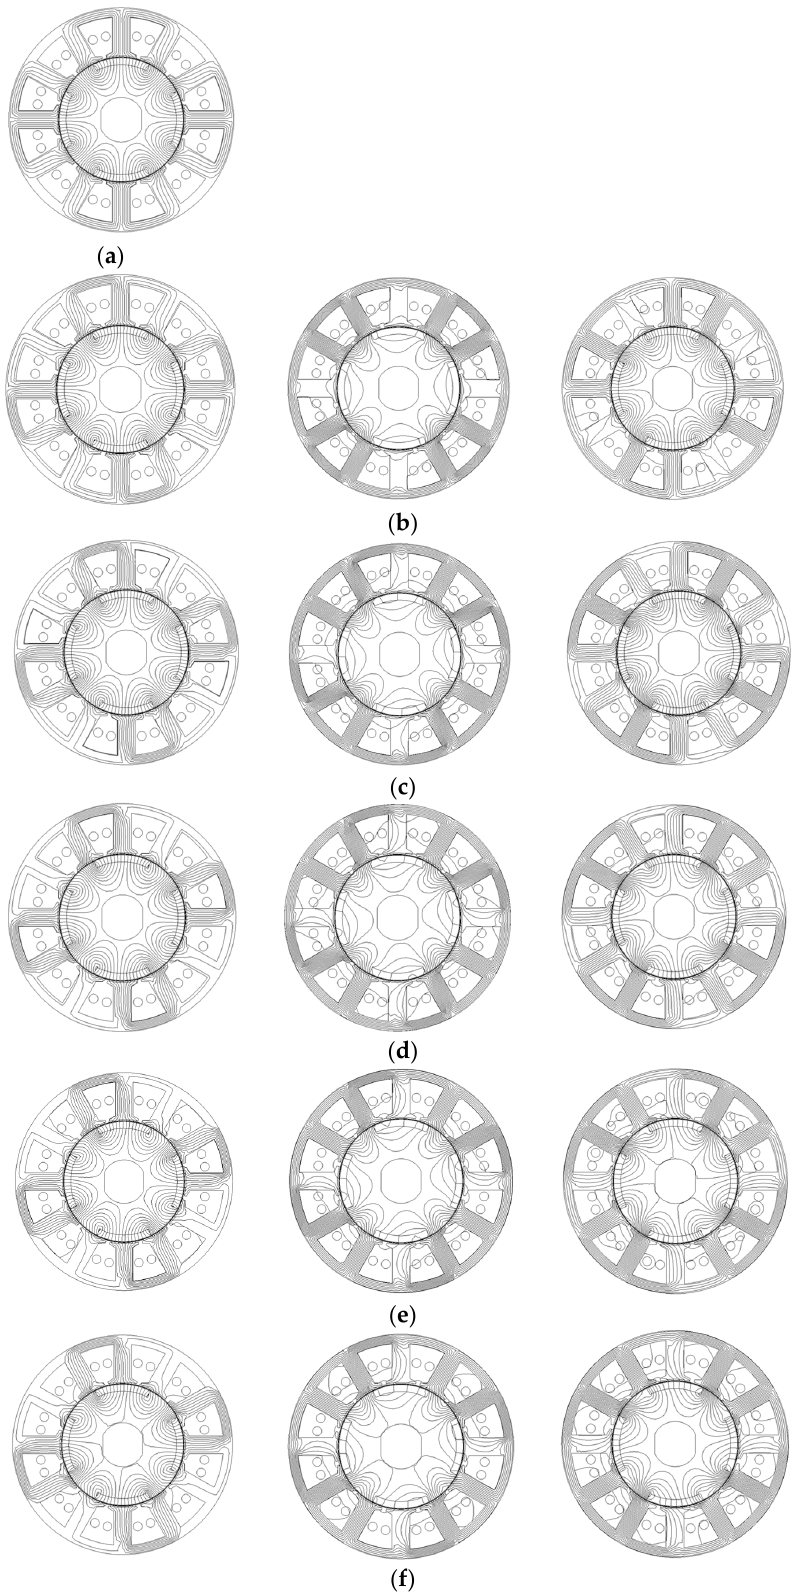
Figure 7. Equal potential distributions for 12s8p-CCPPM. (from left to right: PM only, armature current only, overall) ( a ) 0A. ( b ) 10A ( c ) 20A. ( d ) 30A. ( e ) 40A. ( f ) 50A.